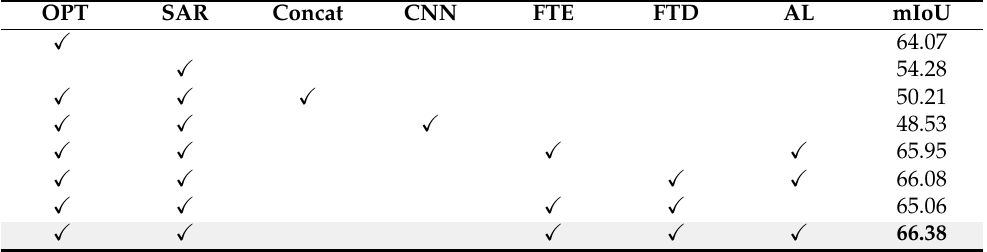
Table 7. Ablation study on